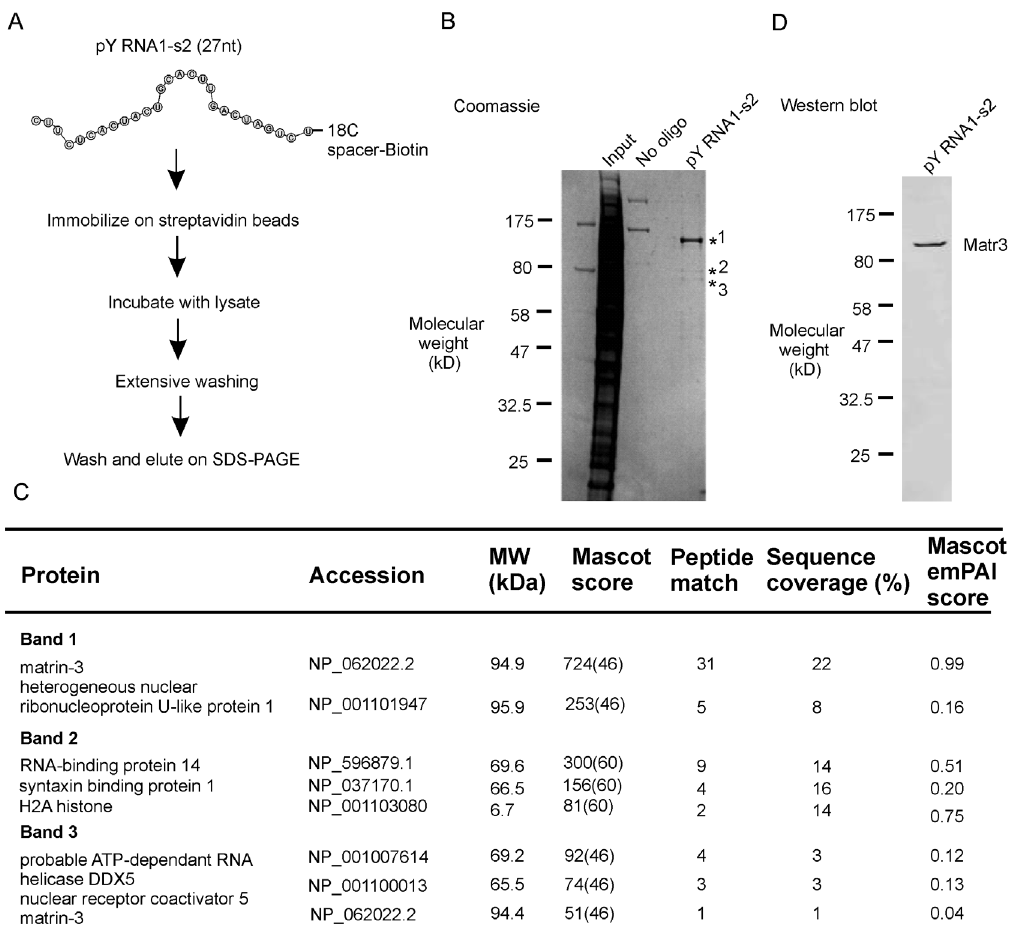
Figure 6. Identification of pY RNA1-s2 interacting proteins by affinity chromatography and mass spectroscopy. A. Scheme of the RNA:protein complex isolation procedure used in this investigation: a biotinylated RNA oligonucleotide corresponding to pY RNA1-s2 was synthesized with an 18C spacer, followed by a Biotin moiety at the 3 9 terminus. The pY RNA1-s2 probe was coupled to streptavidin beads and incubated with lysate prepared from a pool of six rat retinas, followed by extensive washing and elution by SDS-PAGE. B. Coomassie blue staining shows pY RNA1-s2 predominantly associates with a protein migrating at , 120 kDa, indicated with *1. Two minor bands are also present - indicated with *2 and *3; details in the table below. C. Table summarizing LC-MS/MS analysis of pY RNA1-s2-bound proteins. Mascot results were filtered for significance with p , 0.05 and an identity score cut-off value set to report only ion scores with extensive homology. Results are sorted by best Mascot score. Key: Protein – Name of the protein in indicated band, Accession – the RefSeq protein Accession number, MW – Molecular weight in kDa, Mascot score – Probability score calculated by the Mascot search algorithm – parenthesis indicates the value at which the mascot score reaches identity, Peptide match - number of significant peptides recorded for each protein, S equence coverage (%) : sum of amino acids in matching peptides divided by the total number of amino acids in the protein, Mascot emPAI score : provides a measure of protein abundance. See ‘‘Materials and Methods’’ for a full explanation of how the parameters are calculated. D. Confirmation of Matrin3 association with pY RNA1-s2 by western blot, revealed by repeating the experiment performed in A , and using Matr3 antiserum (described in ‘‘Materials and Methods’’).